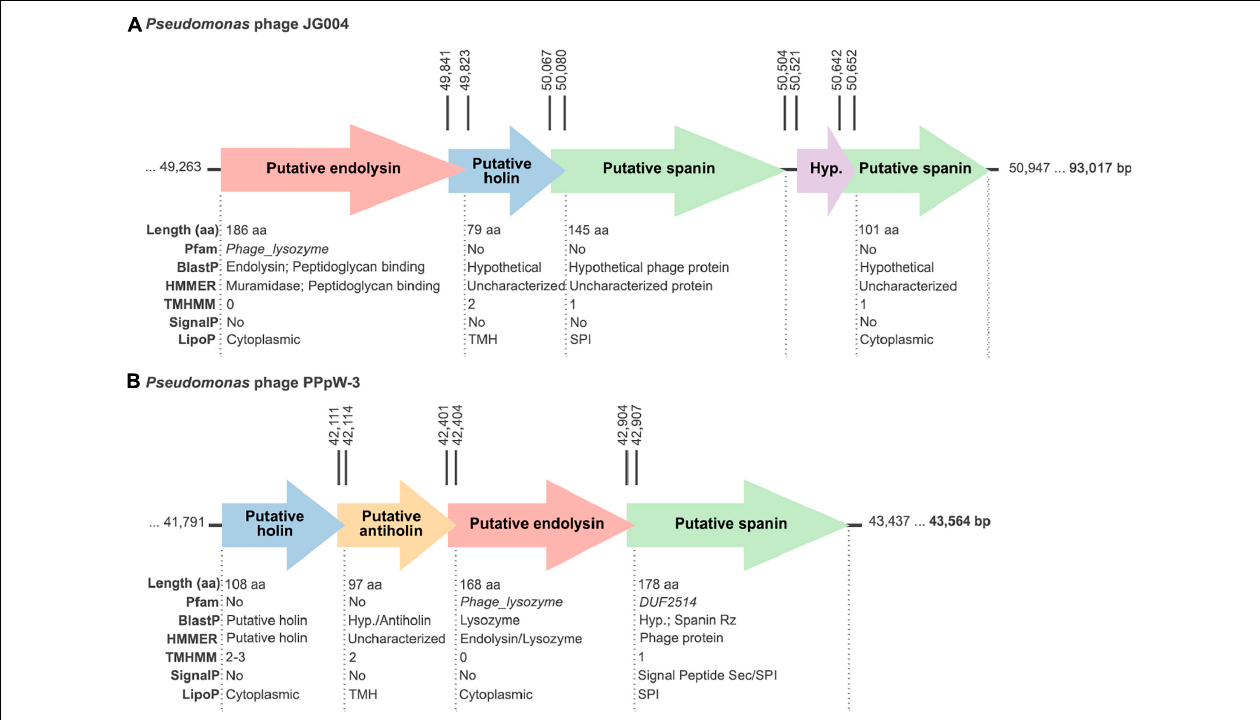
FIGURE 3 | Schemes of the lytic cassettes of the (A) JG004 and (B) PPpW-3 phages. All putatively claimed functions have been proposed based on the bioinformatic analysis results depicted below each open reading frame (ORF). Rightmost, bold numbers indicate the phage genome sizes. Vertical numbers mark the coordinates of the corresponding